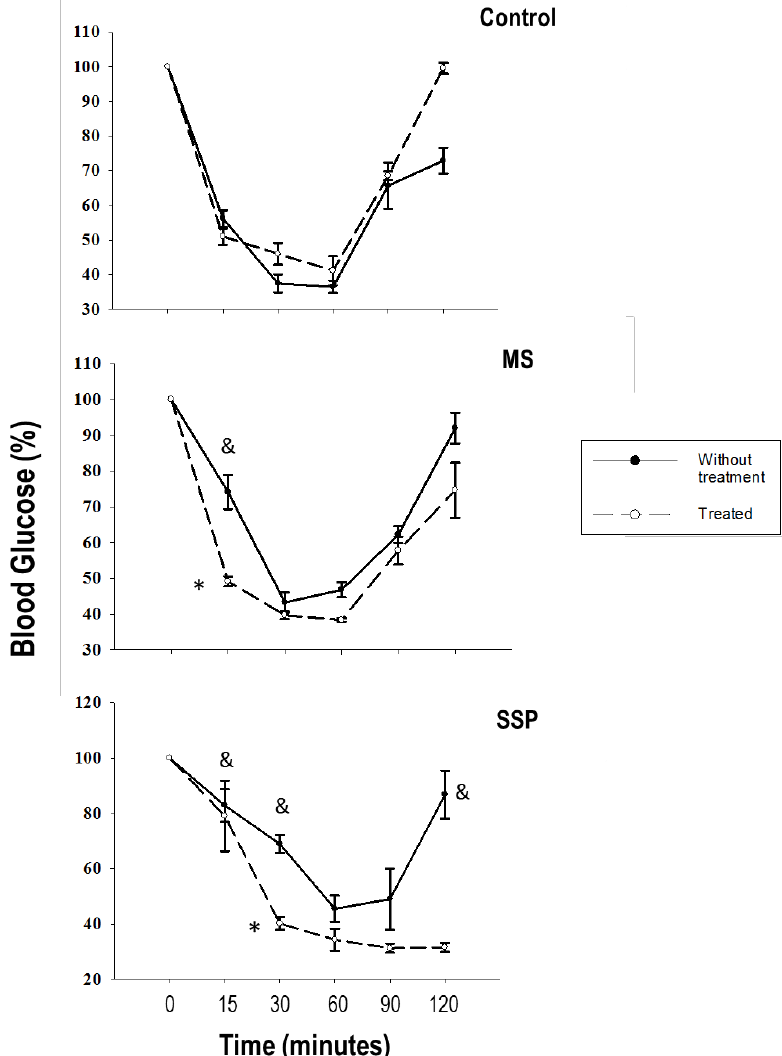
Figure 2. Increased insulin sensitivity caused by treatment for 1 month (from 6 to 7 months of age) with RSV / QSC in rats exposed to short- (SSP) and long- (MS) term sucrose administration. Data represent the mean ± SEM of six di ff erent rats from each group. & p < 0.05 against C group without treatment; * p < 0.05 against respective group without treatment.